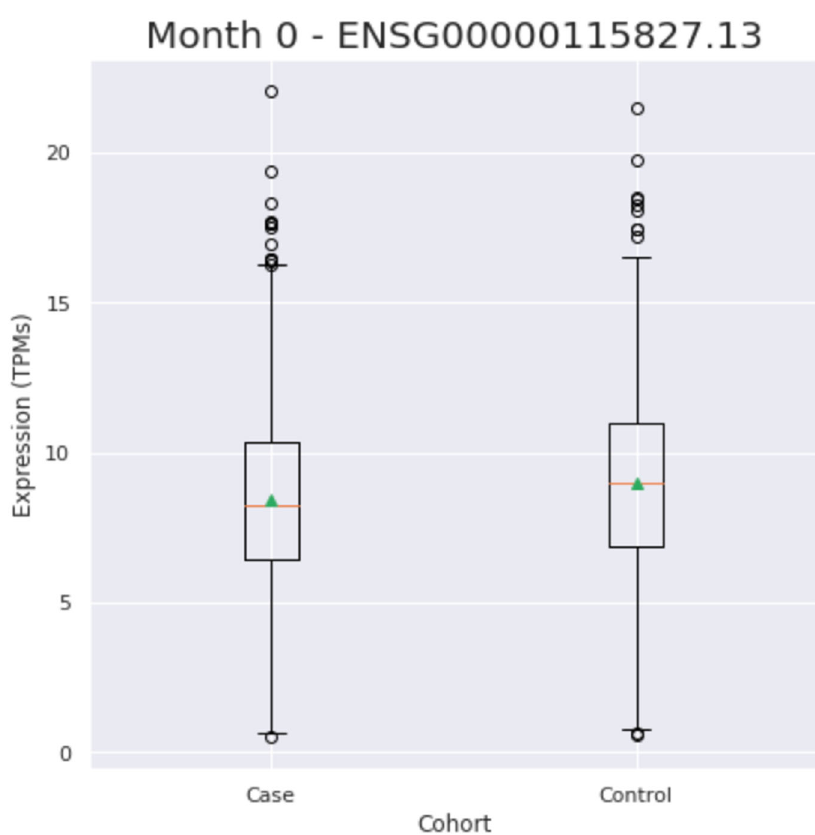
Fig. 1 DCAF17 expression in blood of PD cases versus controls. Center line indicates the median. The box bounds represent the fi rst and third quartiles while the whiskers extend the box by 1.5× the interquartile range (IQR).